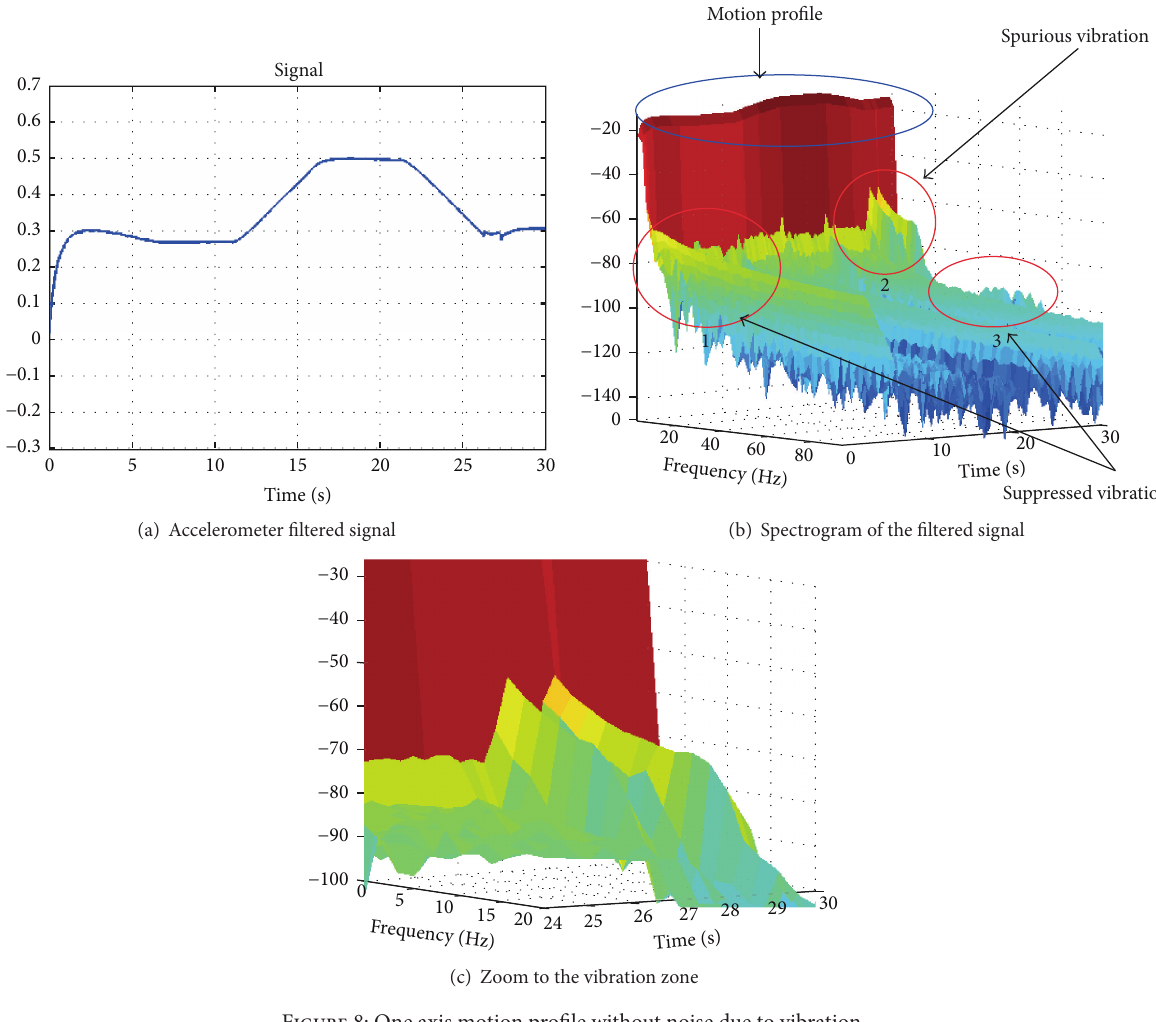
Figure 8: One axis motion profile without noise due to vibration.